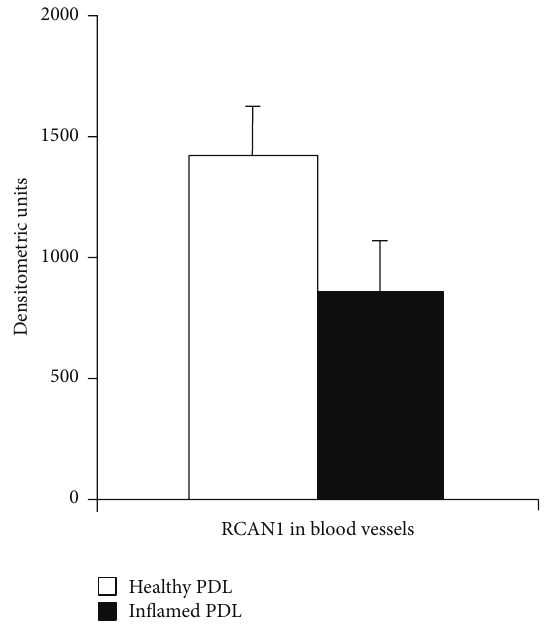
Figure 3: Densitometric analysis of RCAN1 in endothelial cells. Staining intensities (densitometric units) for RCAN1 in healthy and inflamed endothelial cells. Data are mean ± SD.